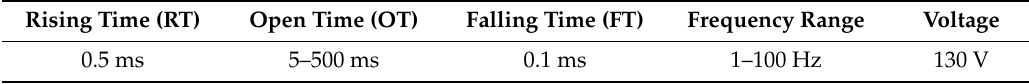
Table 4. Piezo controller settings applied for piezostack